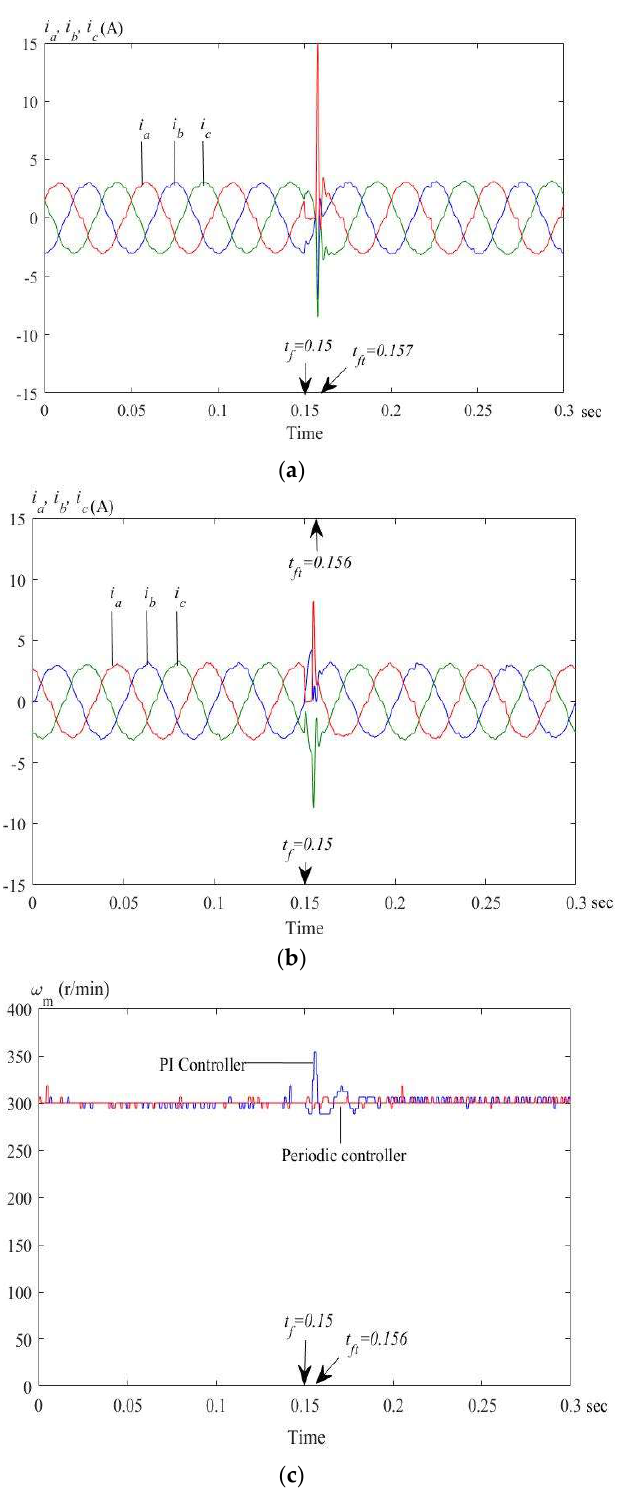
Figure 15. Measured results of the fault-tolerant control when the a -phase was open-circuited: ( a ) currents of the speed-loop PI controller; ( b ) currents of the speed-loop periodic controller; ( c ) speed responses.